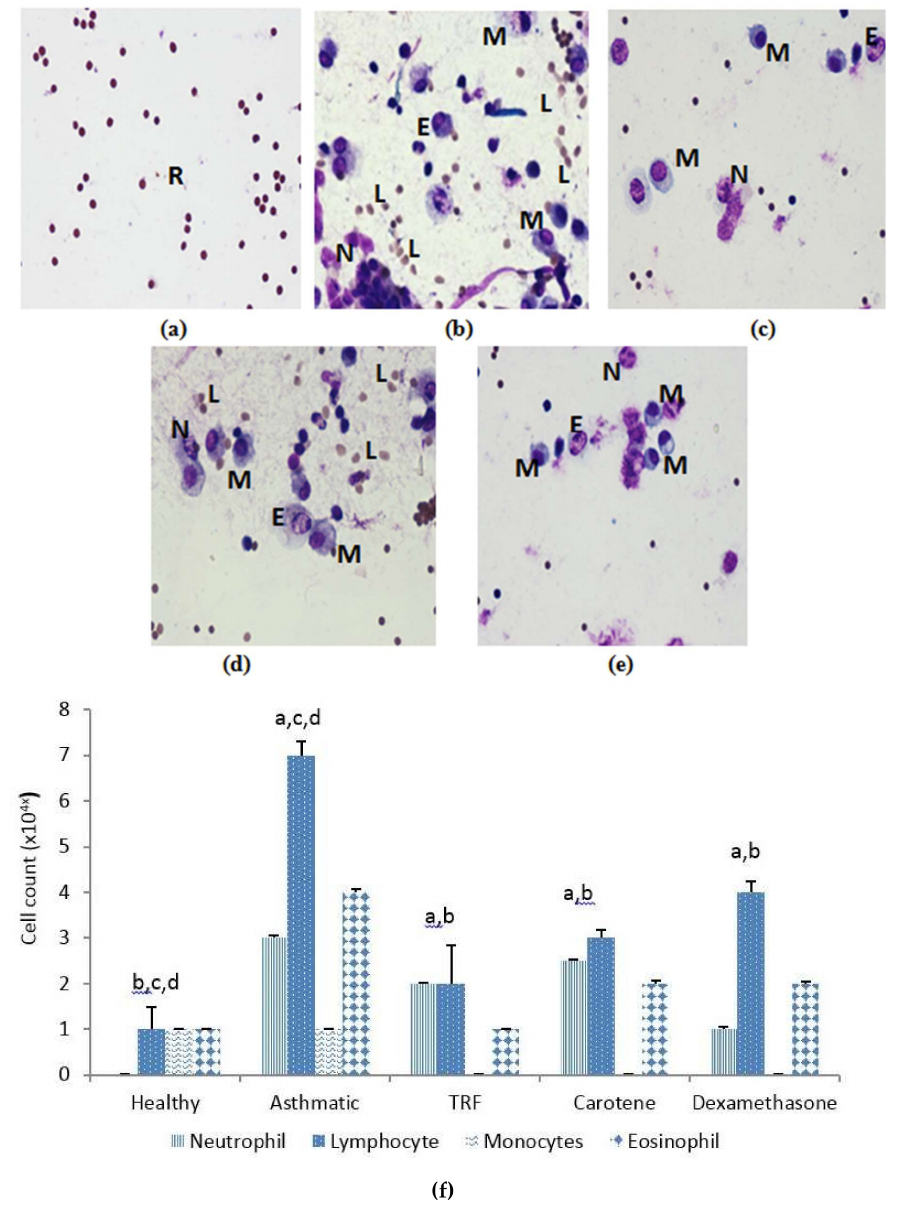
Figure 3. Staining of inflammatory cells from broncho-alveolar lavage (BAL) fluid samples. ( a ) Healthy sample; ( b ) asthmatic sample (+ OVA); and samples treated with TRF (30 mg/kg) + OVA ( c ); carotene (30 mg/kg) + OVA ( d ); and dexamethasone + OVA ( e ). N, neutrophil; E, eosinophil; L, lymphocyte; M, monocyte; R, red blood cell. High magnification 100 × . ( f ). The inflammatory cell count in the BAL fluid samples. The values are expressed as means ± SD ( n = 10). a P < 0.05 versus the control group. b P < 0.05, significantly different from the OVA-challenged group, c P < 0.05 versus OVA + TRF, d P < 0.05 versus OVA +